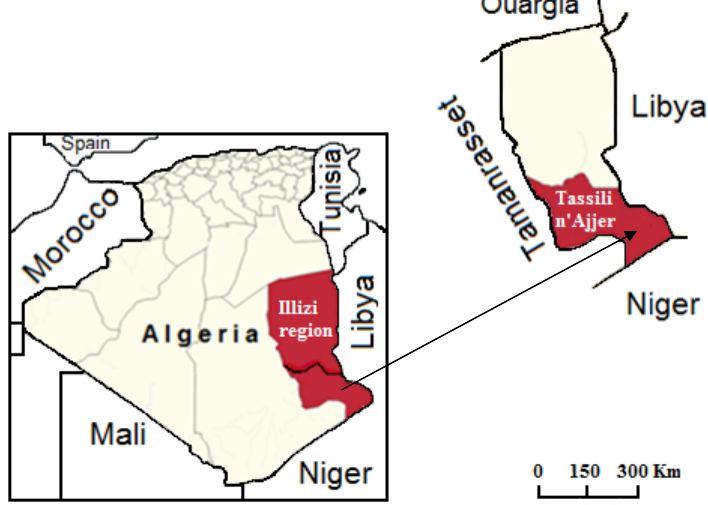
Figure 1. Map showing the Wilaya of Illizi with the geographical location of the study area.